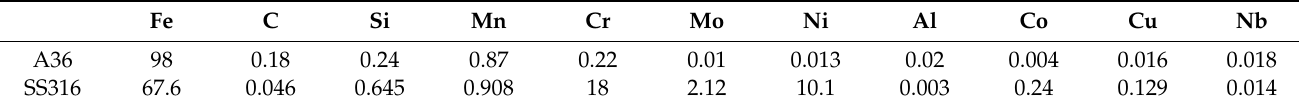
Table 1. Chemical composition of SS316 and ASTM A36 (Unit: